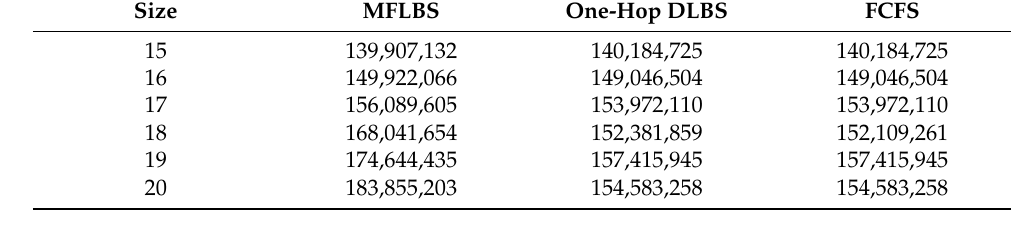
Figure 7. Three algorithms in mesh topology under uniform pattern.